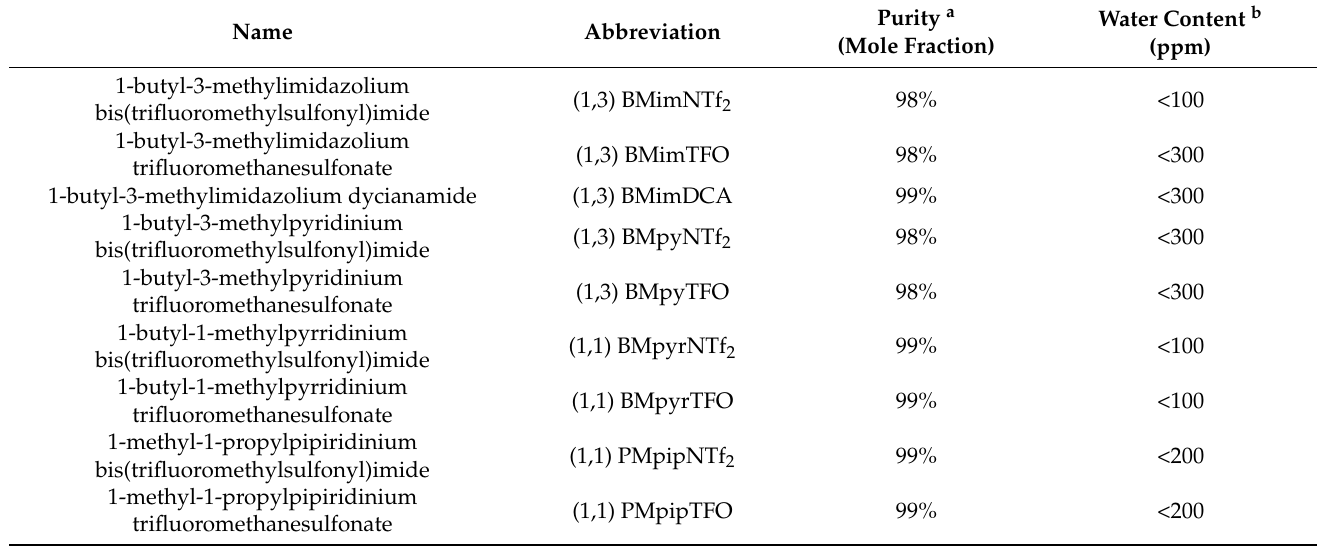
Table 6. Name, abbreviation, purity, and water content of pure ionic